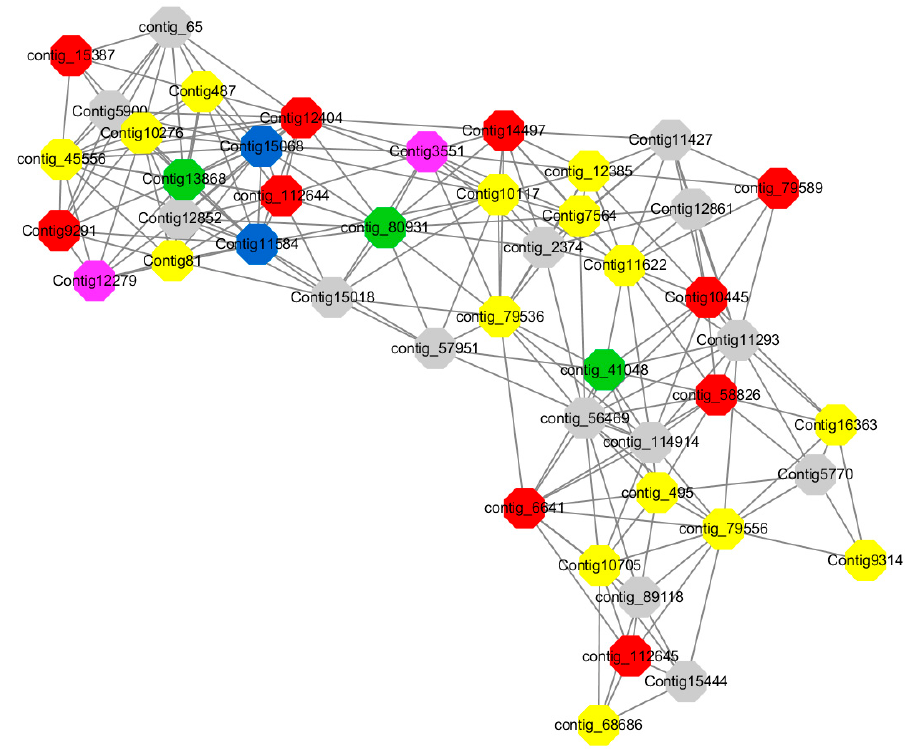
Figure 16. GCN of Module 3.